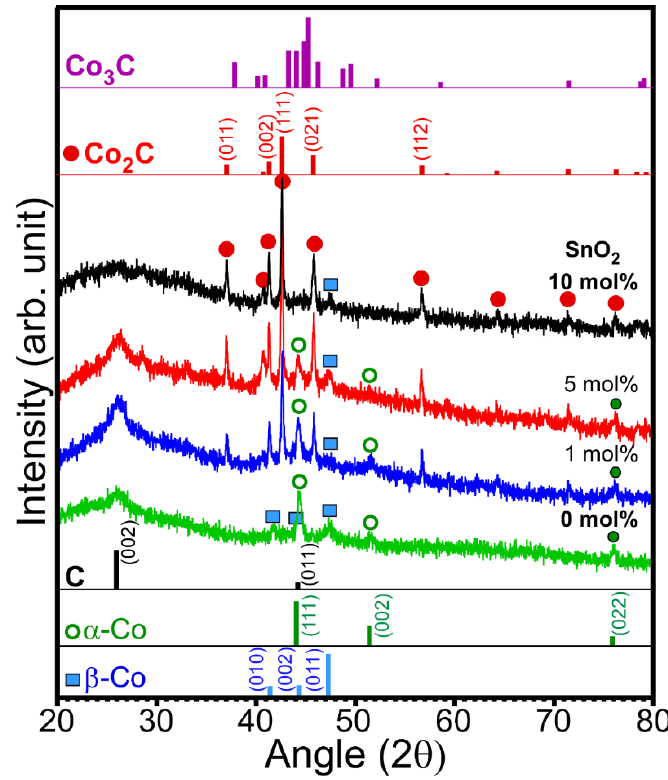
Figure 1. Powder X-ray diffraction patterns of the prepared samples with 0, 1, 5, and 10 mol% of sacrificial SnO 2 . Reference XRD patterns are displayed for β-Co ( ■ ), α-Co ( ), C, Co 2 C ( ), and Co 3 C.